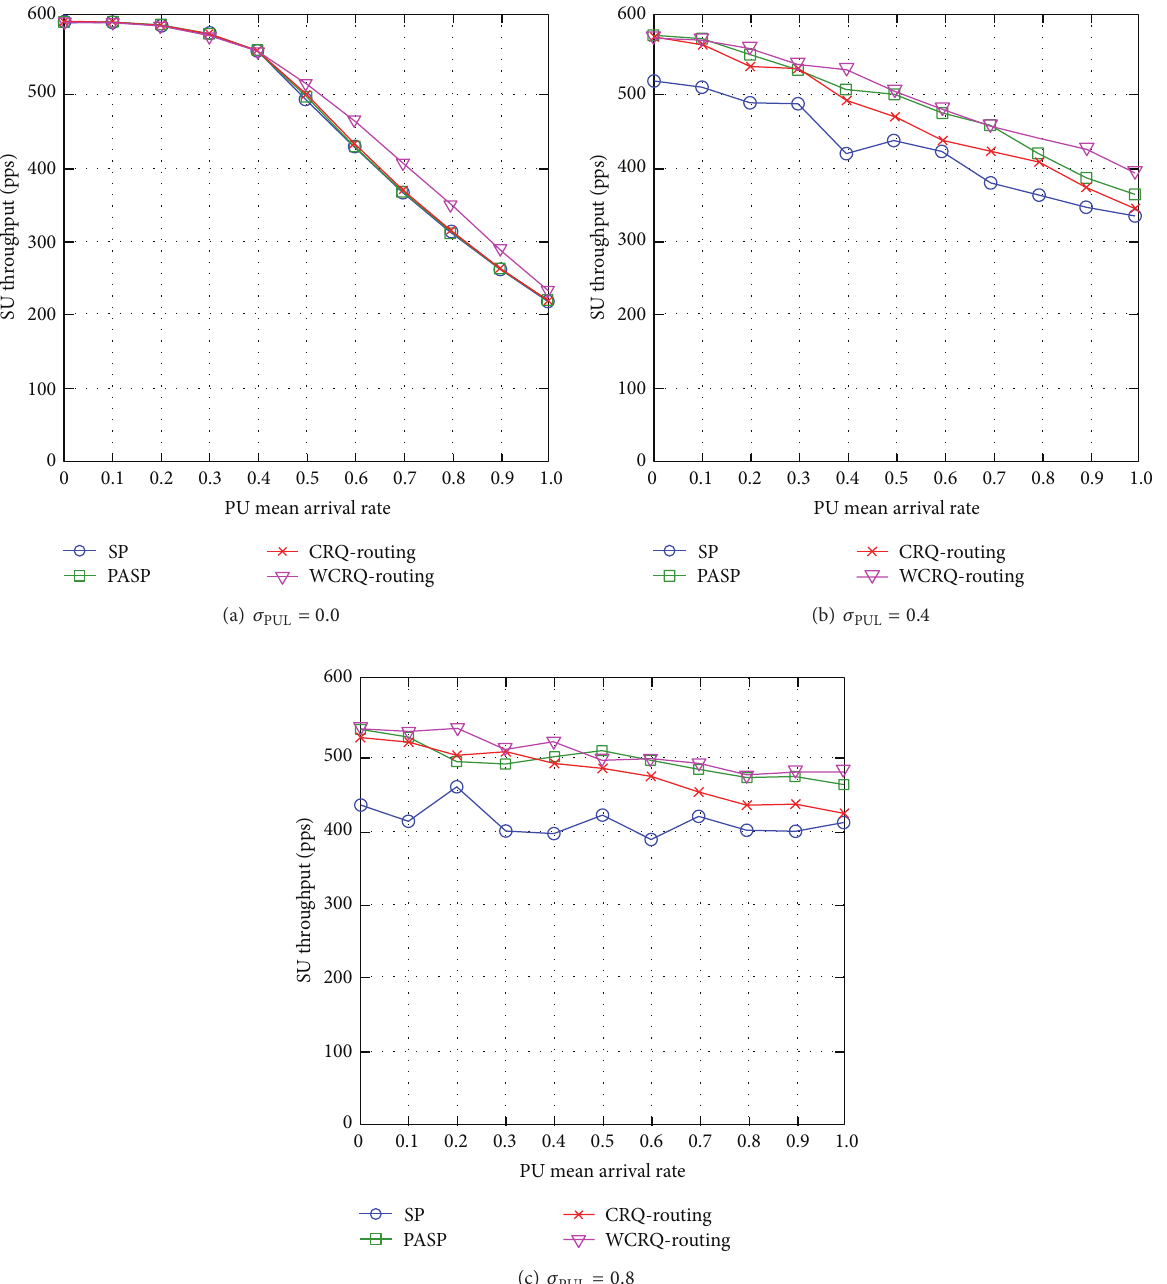
Figure 5: SU throughput for varying PU mean arrival rate 𝜇